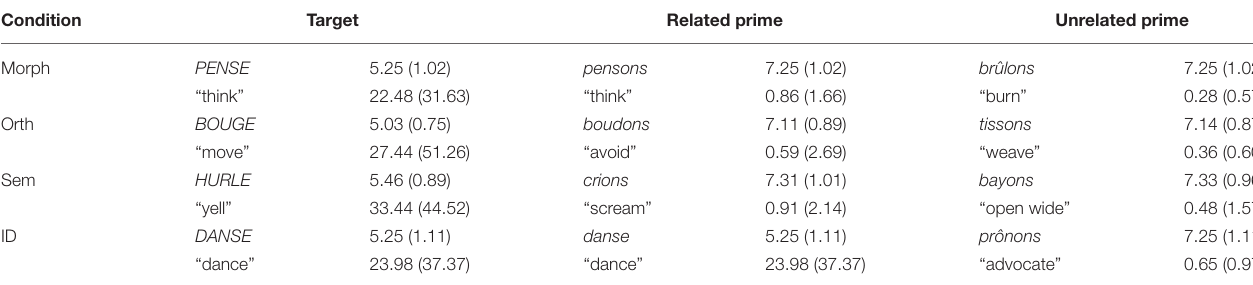
TABLE 1 | Stimuli with Mean (SD) Letter Length (top row) and Frequency (bottom row).